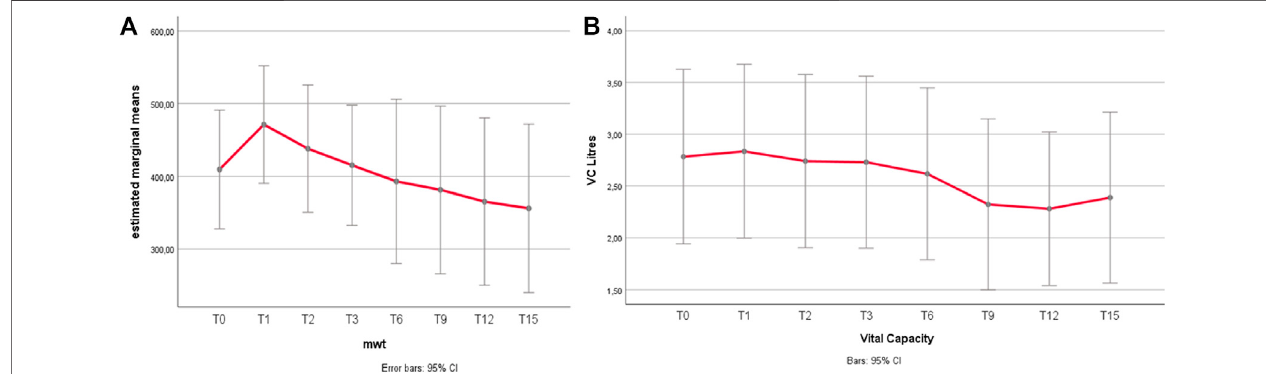
FIGURE1|(A,B) 6MWTandFVCvariationsovertime. (A) 6MWTafteranimprovementduringthe fi rstyearoftreatment,thedistancewalkedatthe6MWTdeclinedgradually. Relative to the baseline, the mean distance walked increased from 367 to 424 m at 1 year ( p (cid:1) 0.010), with a return to baseline (mean 377 m) at 3 years, and a mild decline after 9 years(350 mtatT6vs.330 mtatT9, p (cid:1) 0.282,n.s.;350 mtatT9vs.314 matT12, p (cid:1) 0.007).Greybarsrepresent95%con fi denceinterval(CI). (B) FVCUnlike6MWT,theFVC (forcedvitalcapacity)doesnotshowsigni fi cantchangesundertreatmentformostpartofthefollow-upduration.Theonlysigni fi cantdifferenceisamildworseningtrendofFVC between T6 and T9, being the only signi fi cant change ( p (cid:1) 0.011), with no signi fi cant improvement within the fi rsts 6 years, including the 1st year of